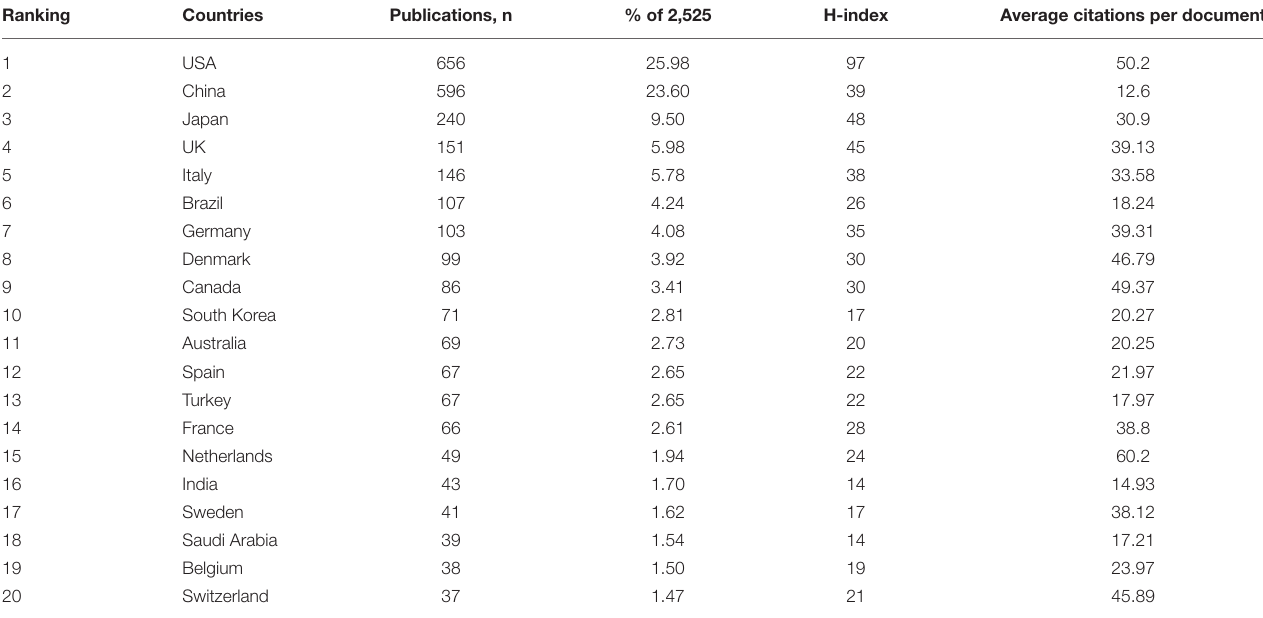
TABLE 1 | Top 20 most productive countries in the research field of BMDM.